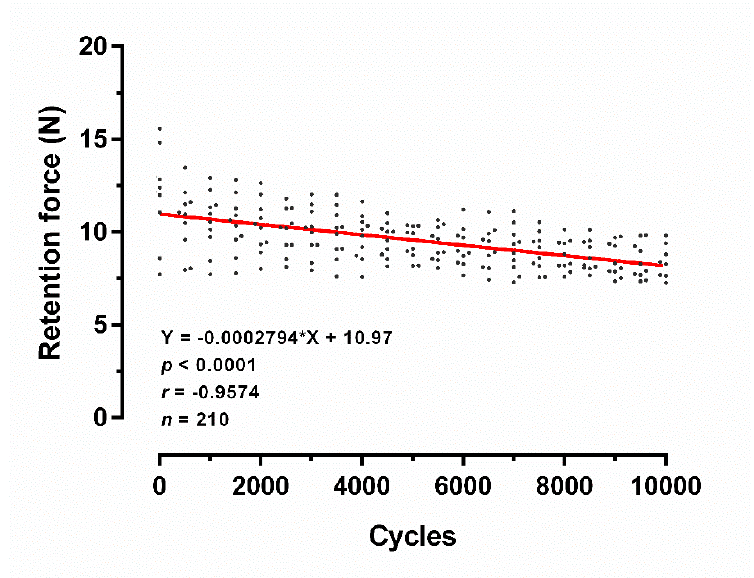
Figure 4. Effect of cyclic dislodgement on the retention force of the PVS attachment (SH60). Linear regression between the cycle’s times and retention force. Black dots represent each measurement at different times of cyclic dislodgement ( n = 210).